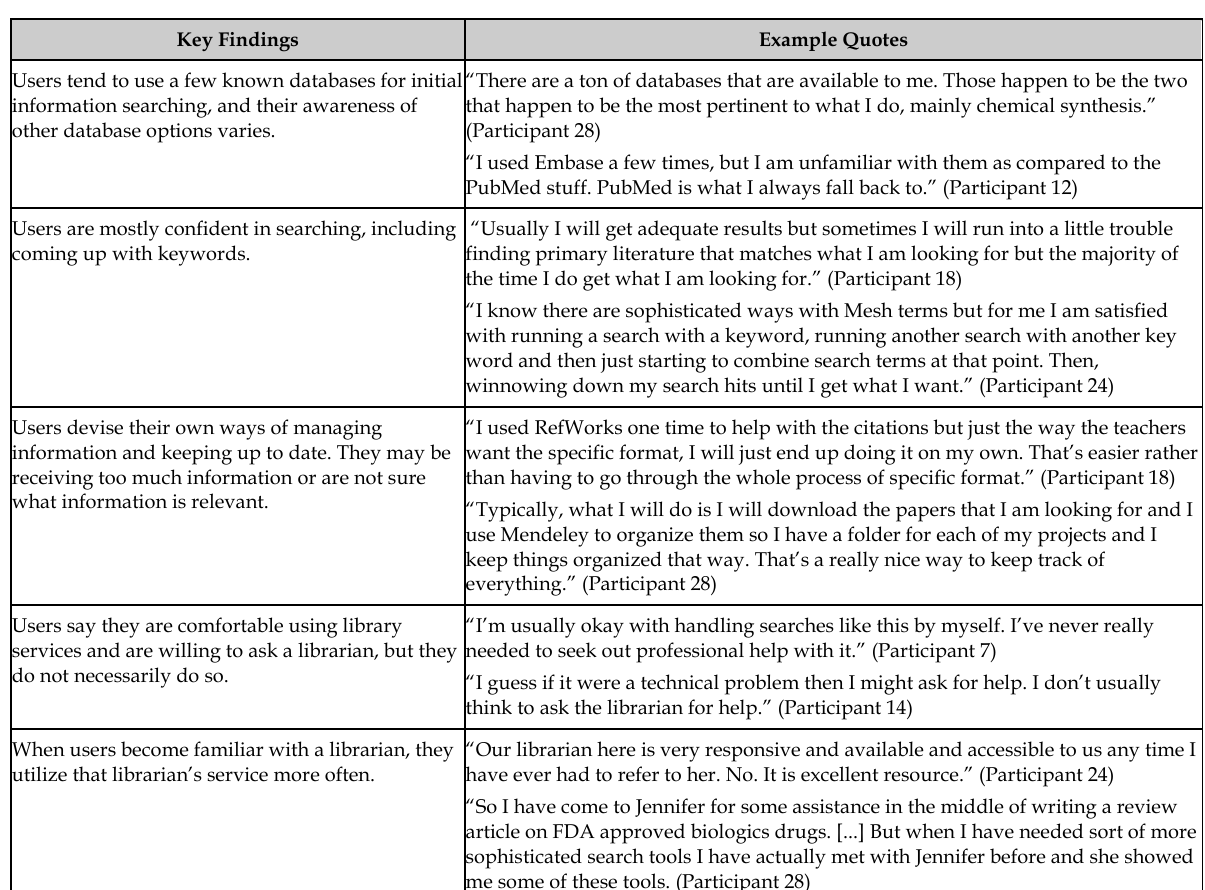
Table 2 Summary of Key Findings and Example Quotes Key